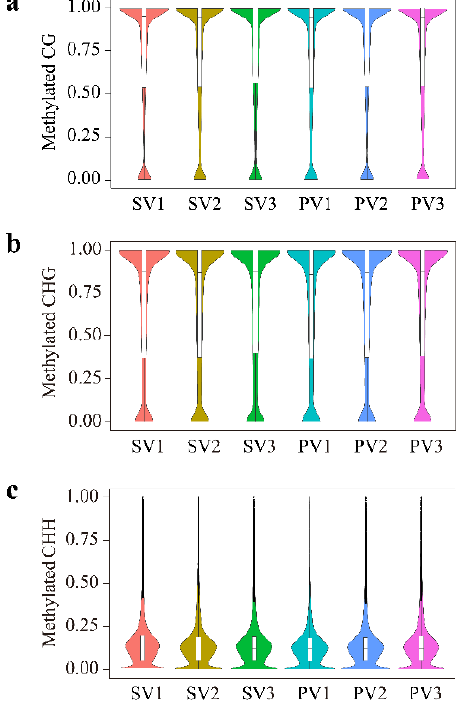
Figure 2. Distribution of methylation levels at single cytosine (C) sites of CG ( a ), CHG ( b ) and CHH ( c ) contexts in pecan grafts (H = A, T, or C). SV1, SV2, SV3: grafts with strong growth vigor; PV1, PV2, PV3: grafts with poor growth vigor. The ordinate represents the methylation level of C sites, and the width of each violin graph represents the density of C sites at that methylation level.